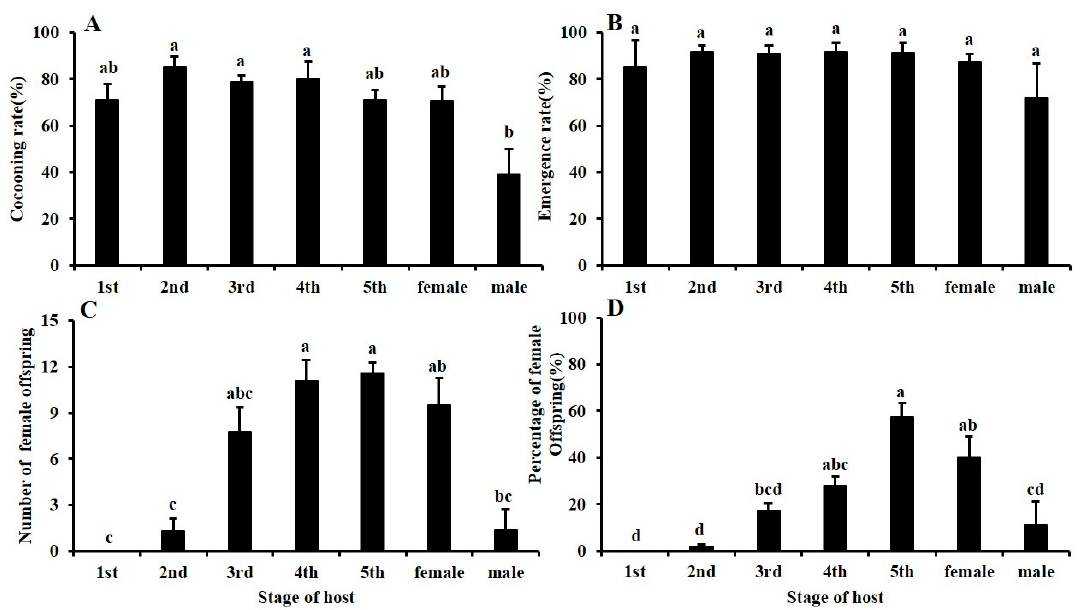
Figure 3. Effects of BPH life stage parasitism on ( A ) cocooning rate, ( B ) emergence rate, ( C ) number of female offspring, and ( D ) percentage of female offspring of G. flavifemur. Among the offspring, the number and percentage of females differed significantly among the seven stages of host development (Tukey’s multiple comparison tests: number: F = 6.85, df = 6/53, p = 0.000, percentage: F = 13.28, df = 6/53, p = 0.000) (Figure 3C,D). The highest number and percentage of females were found for 5th instar hosts (number: 11.6 ± 0.7, percentage: 57.25 ± 6.13%). However, there was no significant difference in the number and percentage of females between the 5th and 4th instar (number: 11.1 ± 1.4, percentage: 27.90 ± 4.11%) and female adult (number: 9.5 ± 1.7, percentage: 40.00 ± 9.02%) hosts. The number of females in the 3rd instar (7.8 ± 1.6) hosts was not significantly different from that in the 5th instar hosts, but the percentage of females in 3rd instar (17.13 ± 3.46%) hosts was significantly lower than that in the 5th instar hosts. These two parameters for adult males (number: 1.4 ± 1.4, percentage: 11.11 ± 10.14%) and 2nd (number: 1.3 ± 0.8, percentage: 1.75 ± 1.11%) and 1st (number: 0, percentage: 0%) instar hosts were all significantly lower than those for 5th instar hosts. In particular, no females emerged from hosts in the 1st instar stage. The developmental time from egg to cocoon significantly differed (Tukey’s multiple comparison tests: F = 17.63, df = 6/55, p = 0.000) (Figure 4A). Indeed, the time for egg to cocoon in 3rd (10.0 ± 0.1 d) and 4th (9.9 ± 0.1 d) instars was significantly longer than that in other stages, with no significant difference among the other stages (1st: 9.2 ± 0.1 d, 2nd: 9.2 ± 0.2 d, 5th: 9.1 ± 0.1 d, male: 8.8 ± 0.1 d, female: 8.7 ± 0.1 d). The developmental time from cocoon to adult also differed significantly among the seven host stages (Tukey’s multiple comparison tests: F = 23.69, df = 6/52, p = 0.000) (Figure 4B). The time from cocoon to adult in the 3rd (12.6 ± 0.1 d) instar was significantly longer than that in other stages, followed by the 5th instar (12.1 ± 0.2 d), which was also significantly longer than the other stages (1st: 11.0 ± 0.2 d, 2nd: 11.1 ± 0.1 d, 4th: 11.4 ± 0.2 d, male: 11.1 ± 0.1 d, female: 11.2 ± 0.1 d). There were no significant differences among the five other stages. The developmental times of males and females from egg to adult were significantly different among all host stages (Tukey’s multiple comparison tests: male: F = 72.50, df = 6/406, p = 0.000; female: F = 27.73, df = 5/137, p = 0.000). The developmental time of males in the 3rd instar (22.5 ± 0.1 d) stage was significantly longer than that of males in the other stages, and that of males in the 4th (20.8 ± 0.1 d) and 5th (21.0 ± 0.2 d) instar stages was significant longer than that of males in the four other host stages (1st: 20.2 ± 0.2 d, 2nd: 20.2 ± 0.1 d, male: 19.7 ± 0.2 d, female: 19.9 ± 0.1 d), and there was no significant difference among the other